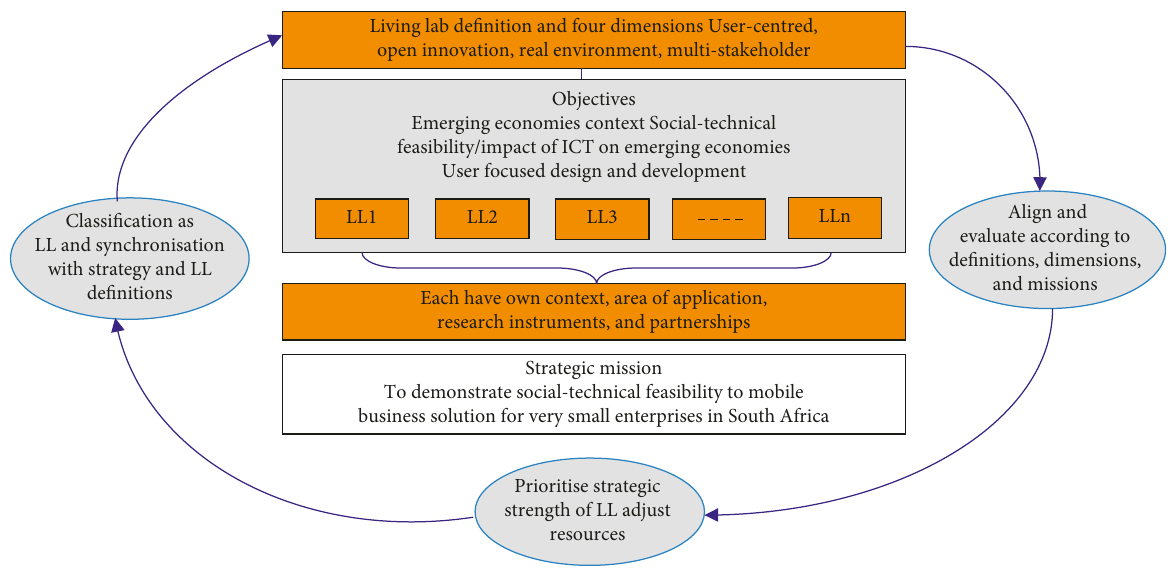
Figure 9: An integrated LL model for effective engagement of ICT in rural education in